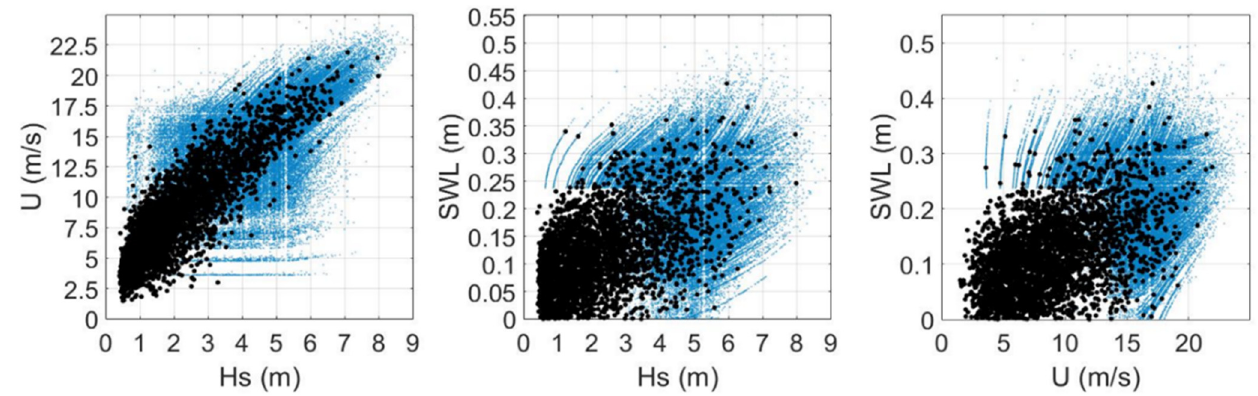
Figure 4. Illustration of Monte Carlo simulation for variables Hs, U, and SWL based on 30 common years of declustered data (black dots). Simulated data (10,000 years simulated) are in blue for the dataset NWW3 560/MARS 8.